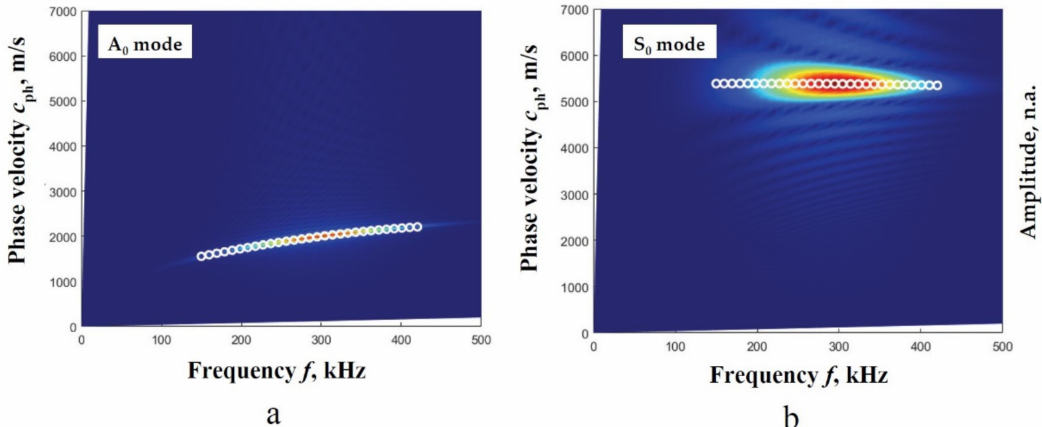
Figure 3. The 2D-FFT spectrum magnitude (presented by the color picture) with the reconstructed phase velocities (presented by white circles) of the A 0 ( a ) and S 0 ( b ) modes by calculating the peak values of spectrum magnitude at particular